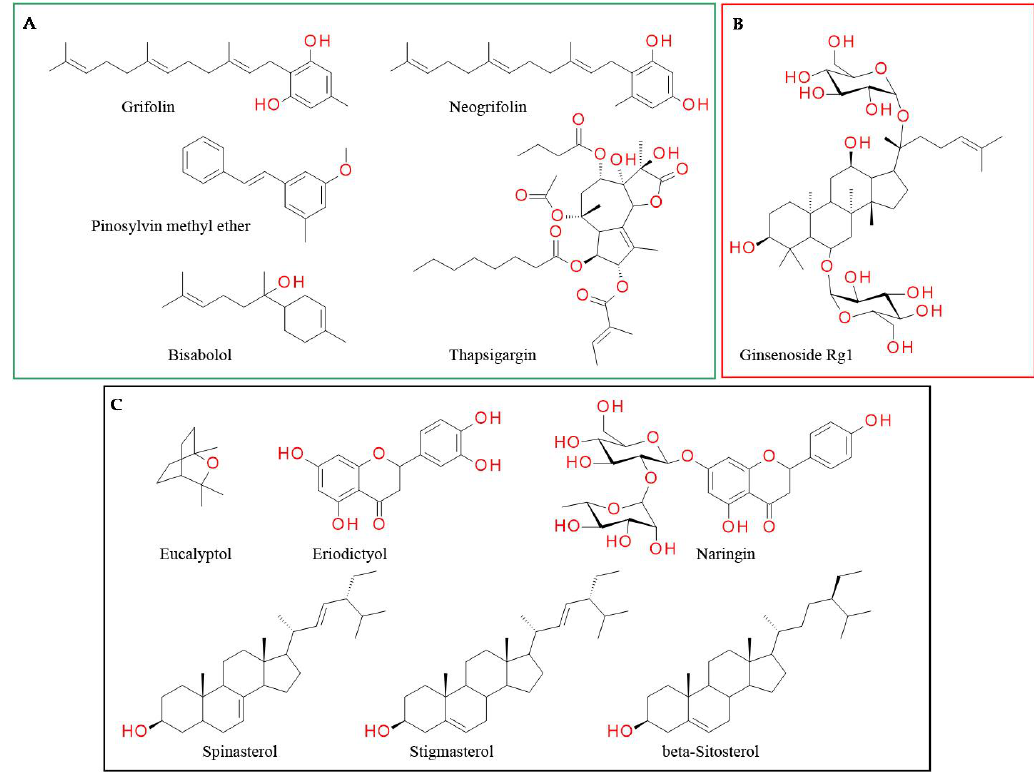
Figure 4. TRPV1 antagonists: ( A ) those whose effect on body temperature is not reported; ( B ) those that increase body temperature; ( C ) those not influencing body temperature.